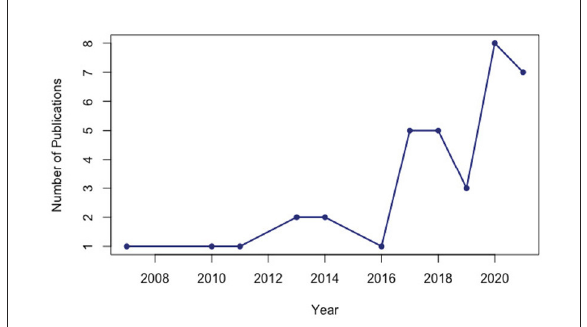
FIGURE2 Annual scientific production.